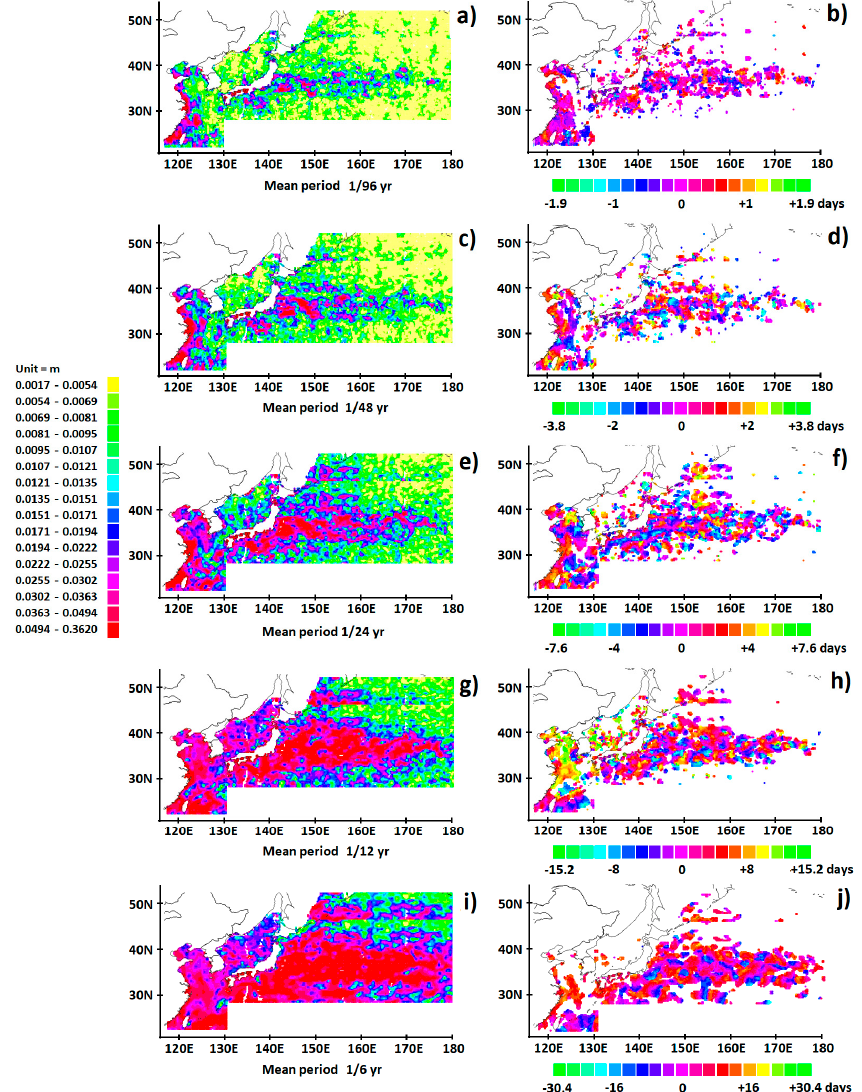
Figure 3. The amplitude ( a , c , e , g , i ) and the phase ( b , d , f , h , j ) of the harmonics of SSH. The periods are 1/6 yr in ( a ), ( b ) 1/12 yr in ( c ), ( d ) 1/24 yr in ( e ), ( f ) 1/48 yr in ( g ), and ( h ) 1/96 yr in ( i , j ). The amplitudes are expressed in 16 classes, each containing the same number of individuals (quantiles). The color of the bar associated with the phase represents an angle varying from − 180° to + 180° [61] (each class corresponds to 20°). This angle is reflected by a segment of time of one period, hence the coincidence of the colors at the ends. Time lags in ( b , d , f , h , j ) are relative to 23 July 2021. The time reference is the SST anomaly averaged along the parallel 34.125° N between 145.625° E and 148.125° E. The SSH anomaly is negative when the time lag is zero (the SSH anomaly is negatively correlated with the SST anomaly and late compared to SST). Only the phase corresponding to the 37.5% quantile of the highest values of the amplitude is displayed. Same data sources as in previous figures.